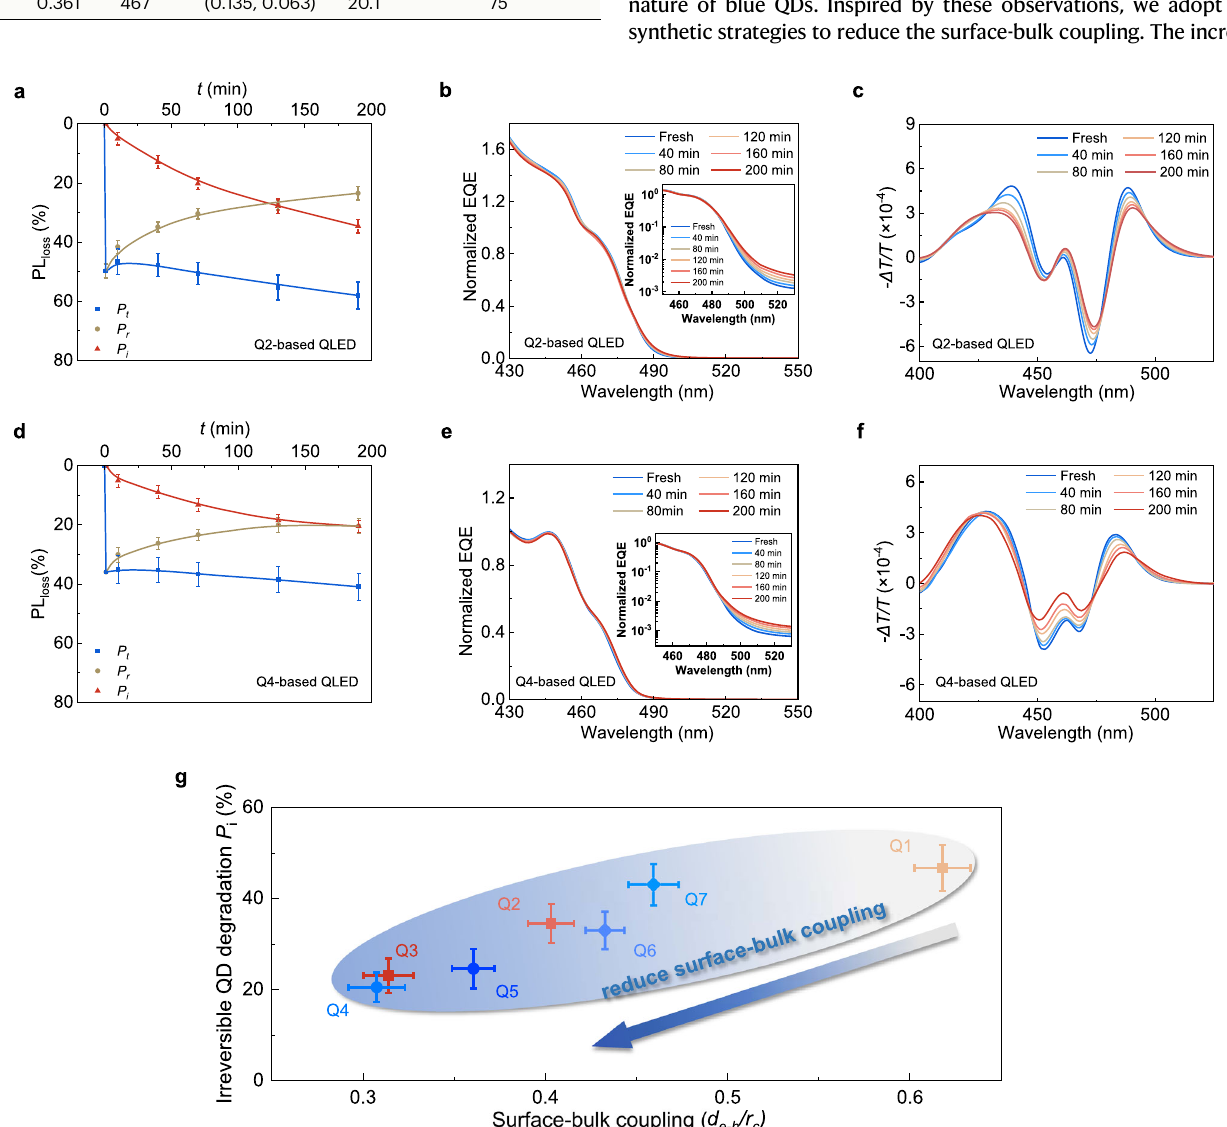
Fig. 4 | Surface-bulk coupling as a primary degradation mechanism. a , d Reversible, irreversible, and total PL loss of Q2 and Q4 measured from cor- responding QLEDs as a function of device operation time. b , e sEQE PV spectra of Q2- and Q4-based QLEDs. The inset shows the same sEQE PV plotted on a loga- rithmicscaletodemonstratethenear-band-edgetransitions. c , f Electroabsorption spectraofQ2-and Q4-basedQLEDsmeasuredasafunctionofoperationtime.The devices for time-dependent spectral analysis are aged by a constant current